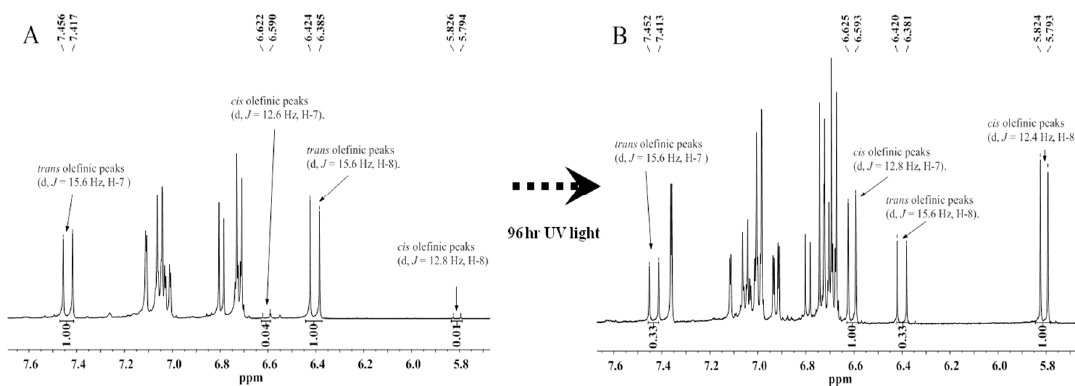
Figure 4. 1 H-NMR (600 MHz) spectra of compound 2 , which was isolated with a purity of ≥ 95% ( A ); and fully converted compound 2 after 96 h of UV (245 nm) exposure (B).